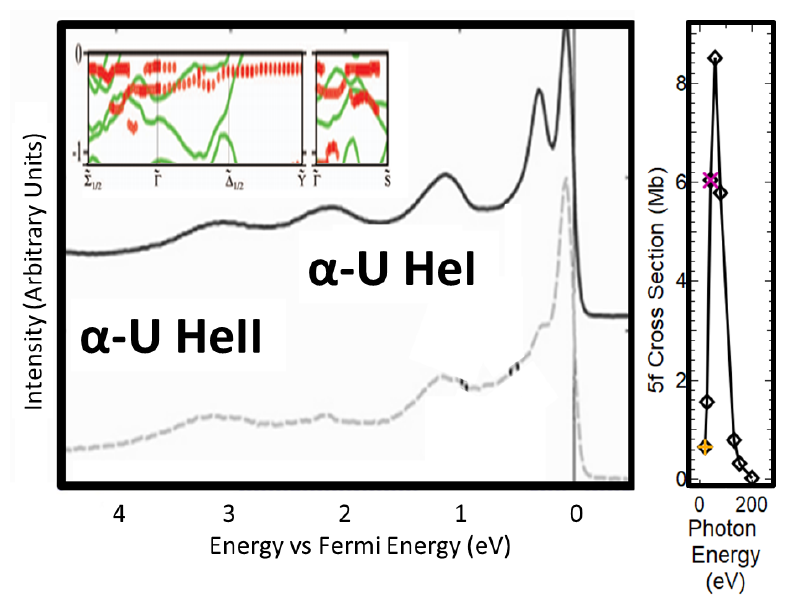
Figure 6. Left panel: Photoelectron spectroscopy data, i.e., intensity as a function of binding energy for HeI (hv = 21.2 eV, solid black line) and HeII (hv = 40.8 eV, dashed gray line) of single crystal U (001) at T = 173 K, are shown here. The Fermi energy is at 0 eV. Left panel insets: Positions of the local maxima (red) in the ARPES intensity map, together with the corresponding calculated band structure (green) (taken from References [24,25] with permission). Right panel: Cross sections for the U 5f versus photon energy. HeI is marked with an orange +. HeII is marked with a purple x. Data taken from Reference [36].